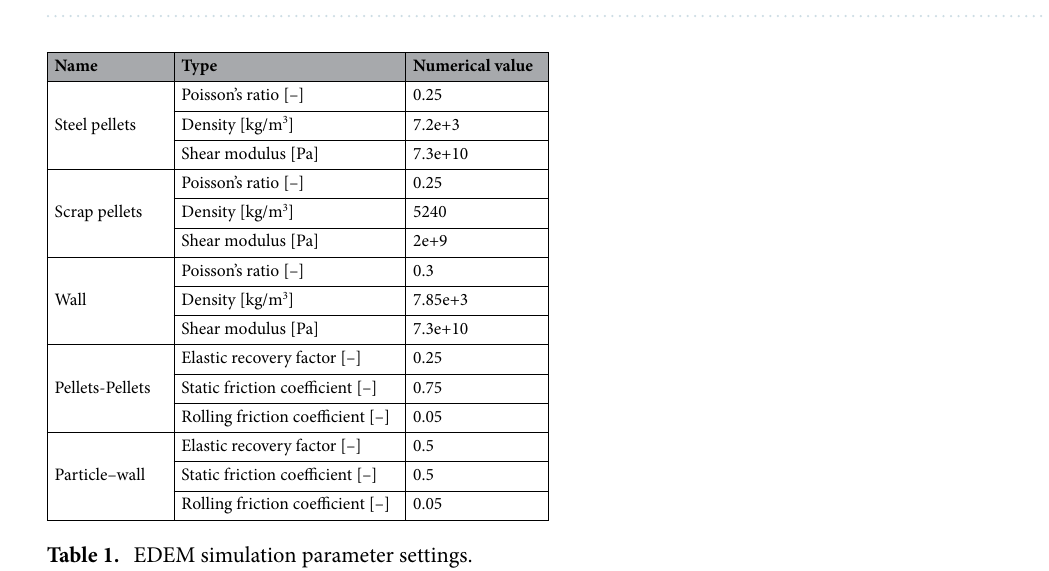
Figure 5. Simplified process diagram of particles ( a ) steel shot physical picture ( b ) steel shot size measurement ( c ) simplified steel shots model ( d ) physical diagram of waste ( e ) particle magnification diagram ( f ) waste particles under ultra-depth of field microscope ( g ) simplified waste particles model.